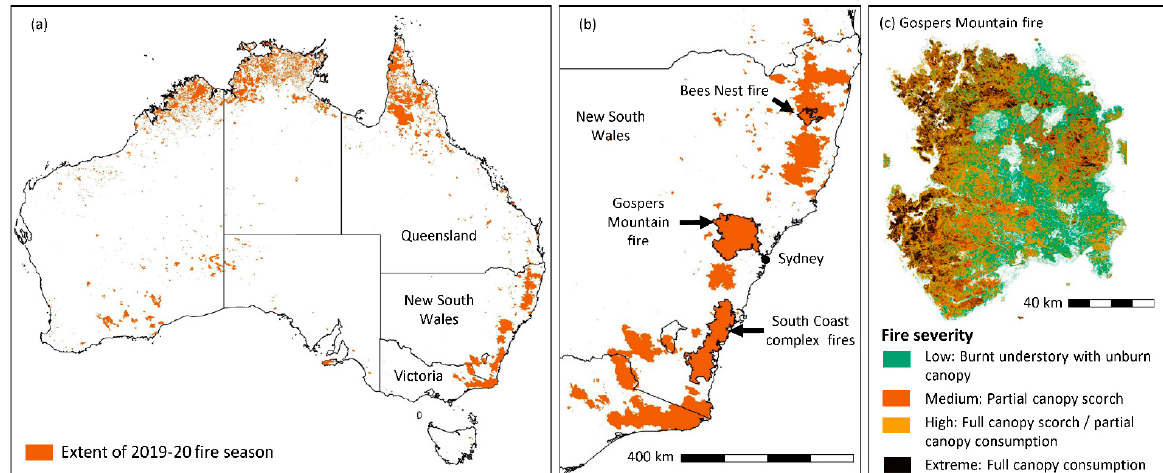
Figure 1. ( a ) Extent of the 2019-20 Black Summer fire season, ( b ) extent of fires in south-eastern Australia, showing the extent of the Bees Nest fire, Gospers Mountain fire and South Coast complex fires, which are used as case study fires for analyses on the effects of antecedent hazard reduction burns. ( c ) Fire severity of the Gospers Mountain fire, the largest of the fires at 512,000 ha. Fire severity sourced from the State Government of NSW [20] .